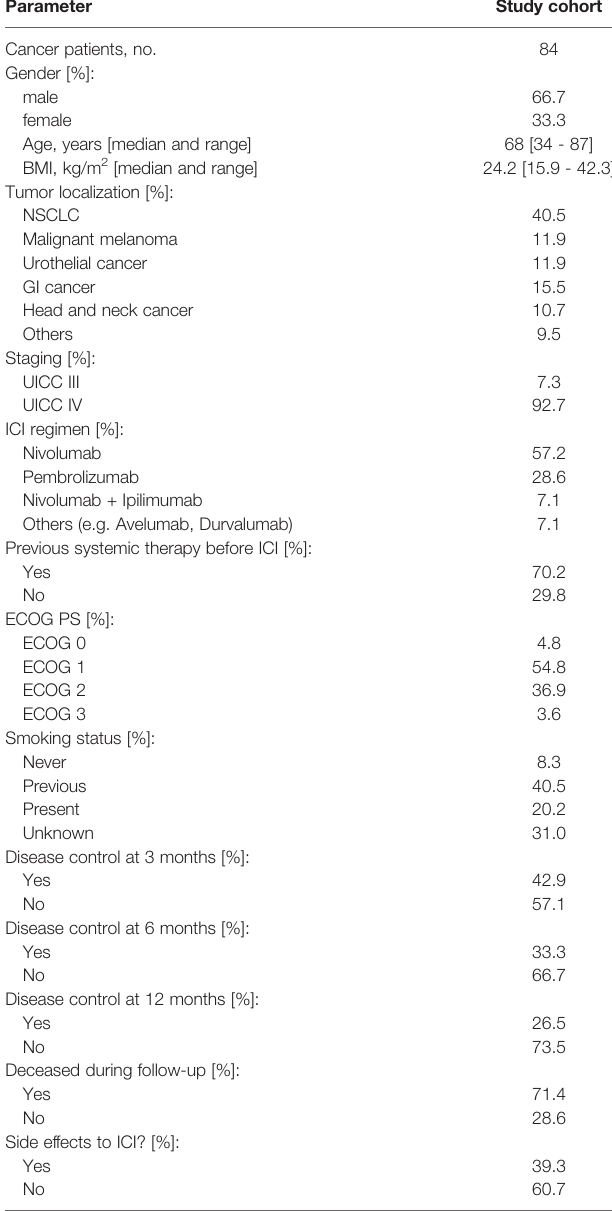
TABLE 1 | Patient